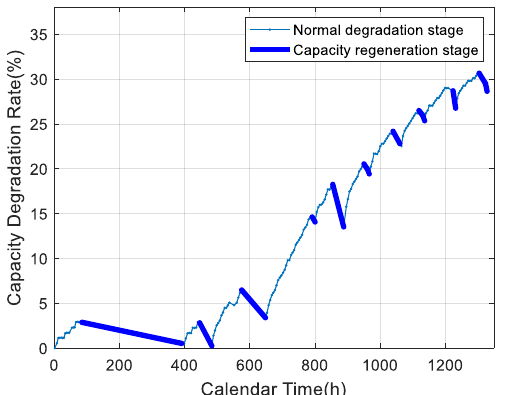
Figure 2. Degradation process curve of No. 5 battery.